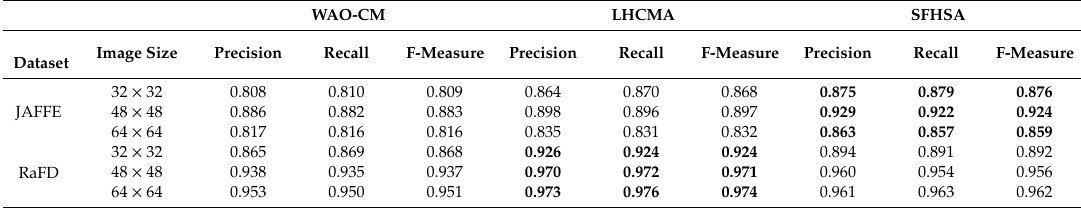
Table 11. Performance of SFHSA with respect to WAO-CM and LHCMA for HOG features in terms of Precision, Recall and F-measure.